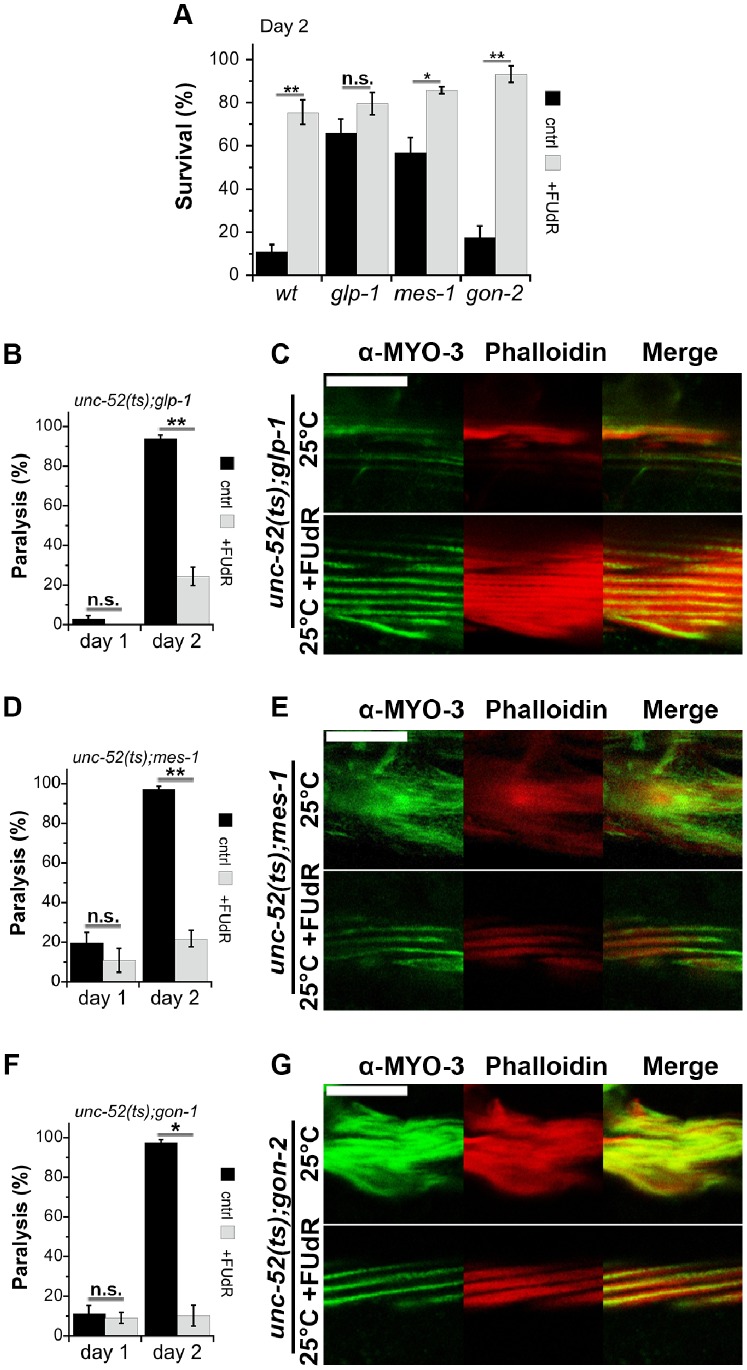
FUdR treatment modulates proteostasis of germline- and gonadogenesis-defective mutants upon transition to adulthood.(A) Age-synchronized glp-1(e2141), mes-1(bn7) or gon-2(q388) animals raised in the absence (black) or presence (gray) of FUdR were exposed to a 37°C HS for 6 h on the second day of adulthood and survival was assayed. Data represent means ± SEM of >5 independent experiments. P values compare age-matched treated and untreated animals. (*) P<0.05, (**) P<0.01 and (n.s.) not significant. (B) The motility of age-synchronized unc-52;glp-1 animals raised in the absence (black) or presence (gray) of FUdR was examined on the second day of adulthood and the percent of paralyzed animals was scored. Data represent means ± SEM of >4 independent experiments. P values compare age-matched treated and untreated animals. (*) P<0.05, (**) P<0.01 and (n.s.) not significant. (C) Confocal images of age-synchronized unc-52;glp-1 animals raised in the absence or presence of FUdR, and stained with anti-MYO-3 antibodies (green) and Phalloidin (red). Scale bar is 10 µm. (D) The motility of age-synchronized unc-52;mes-1 was examined as in B. (E) Confocal images of age-synchronized unc-52;mes-1 as in C. (F) The motility of age-synchronized unc-52;gon-2 was examined as in B. (G) Confocal images of age-synchronized unc-52;gon-2 as in C. Scale bar is 10 µm.